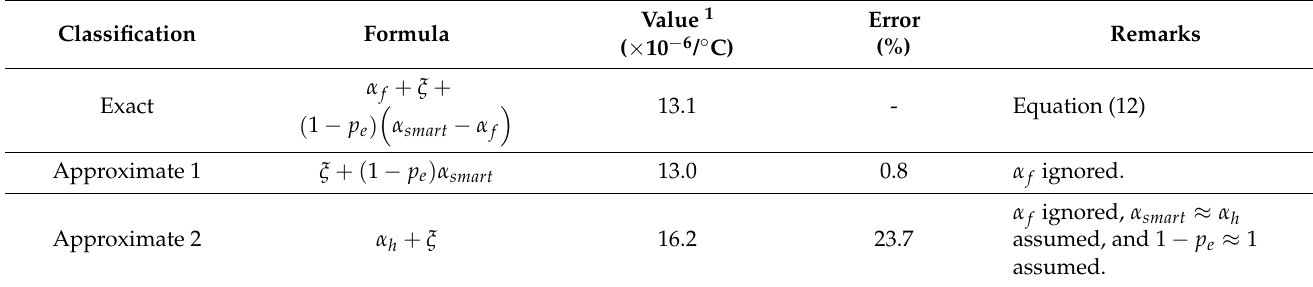
Table 1. Comparison of theoretical thermal sensitivity of a Smart Strand ( K T , smart ).